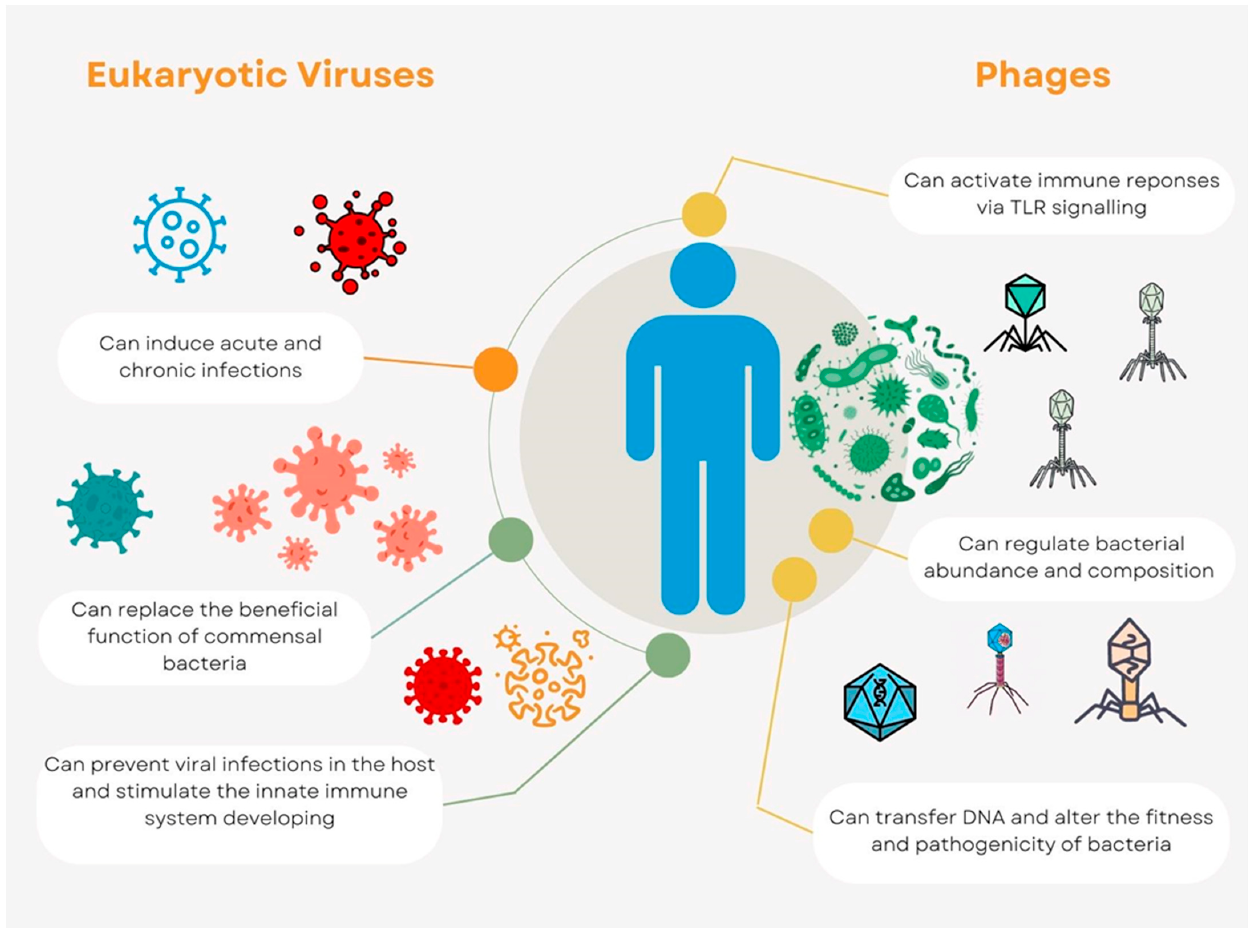
Figure 1. Virome interconnections with host. The host health is impacted by eukaryotic viruses in both negative and positive ways (green and orange lines, respectively). Phages interact with the host through the bacterial population that is associated with it, and these interactions, either directly or indirectly, could have unknown implications (yellow lines) on human health.